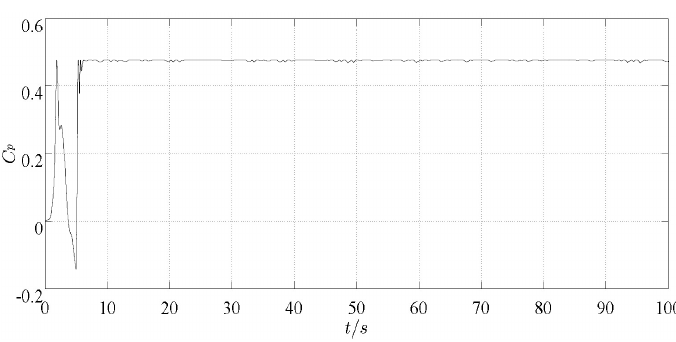
Figure 5. Reference value of electromagnetic torque Γ ∗